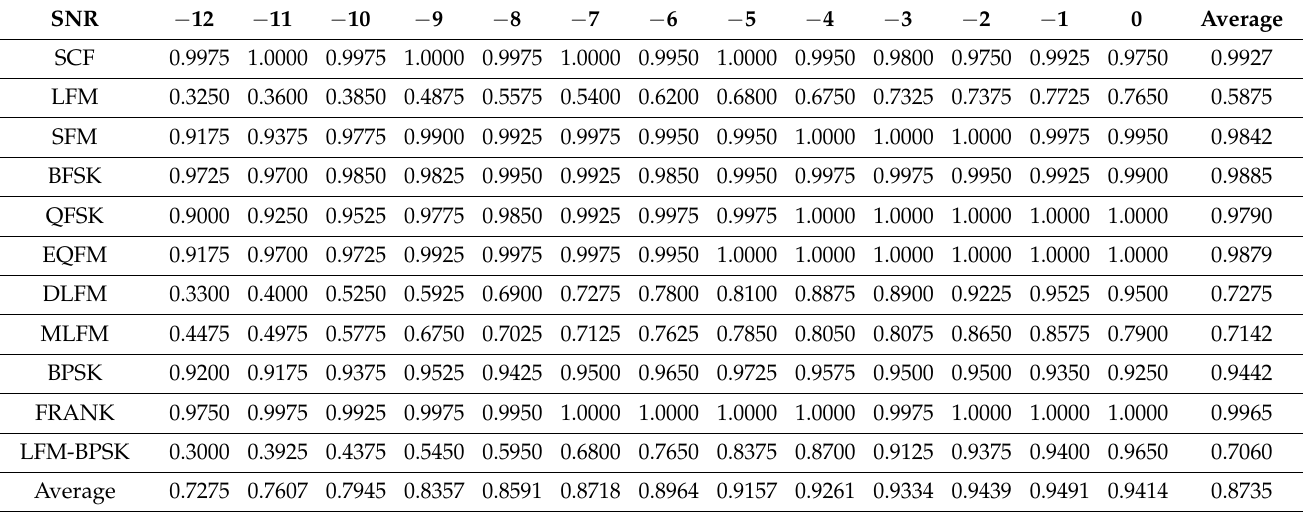
Table A8. Semi-supervised classification results with the datasets in Situation Dataset 4 ( T cycle = 50, NUM = 1102).